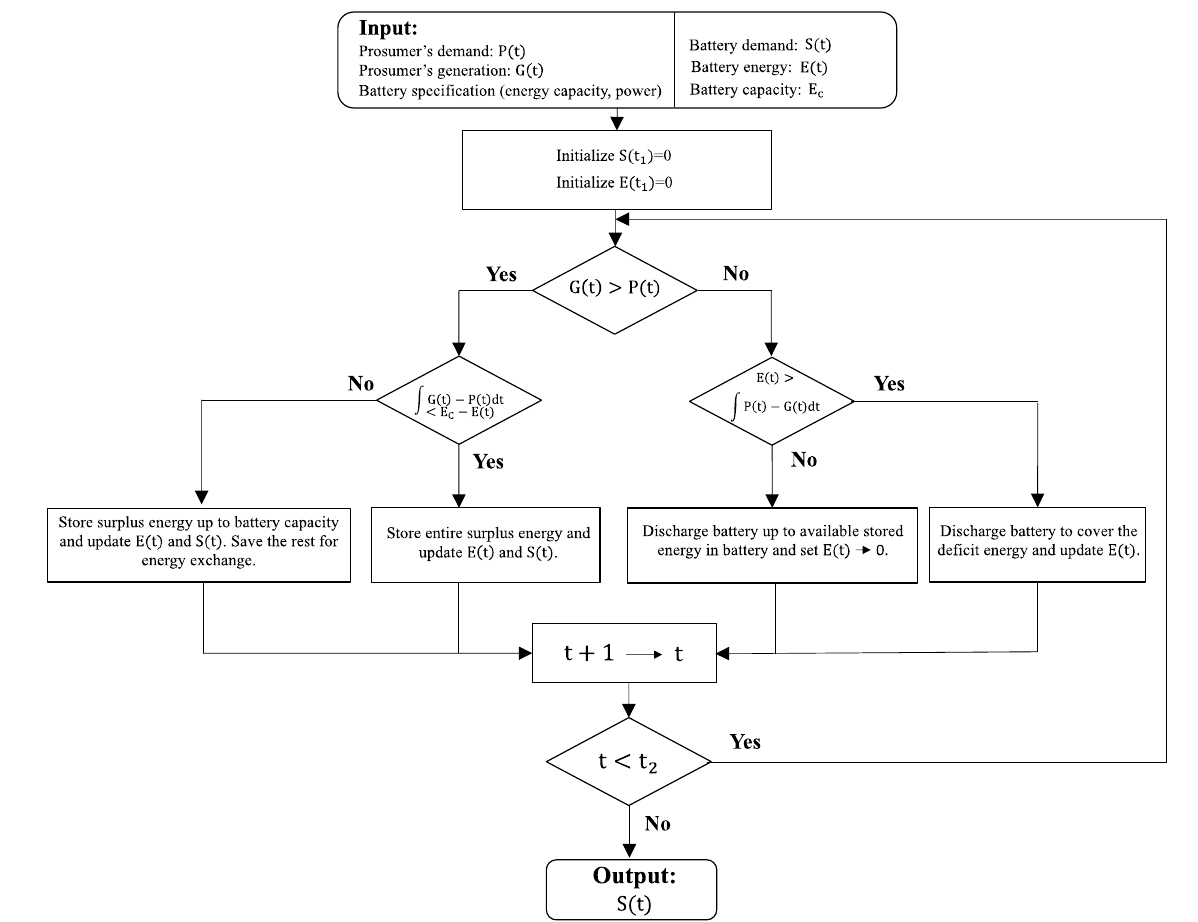
Figure 1. Battery scheduling flowchart.